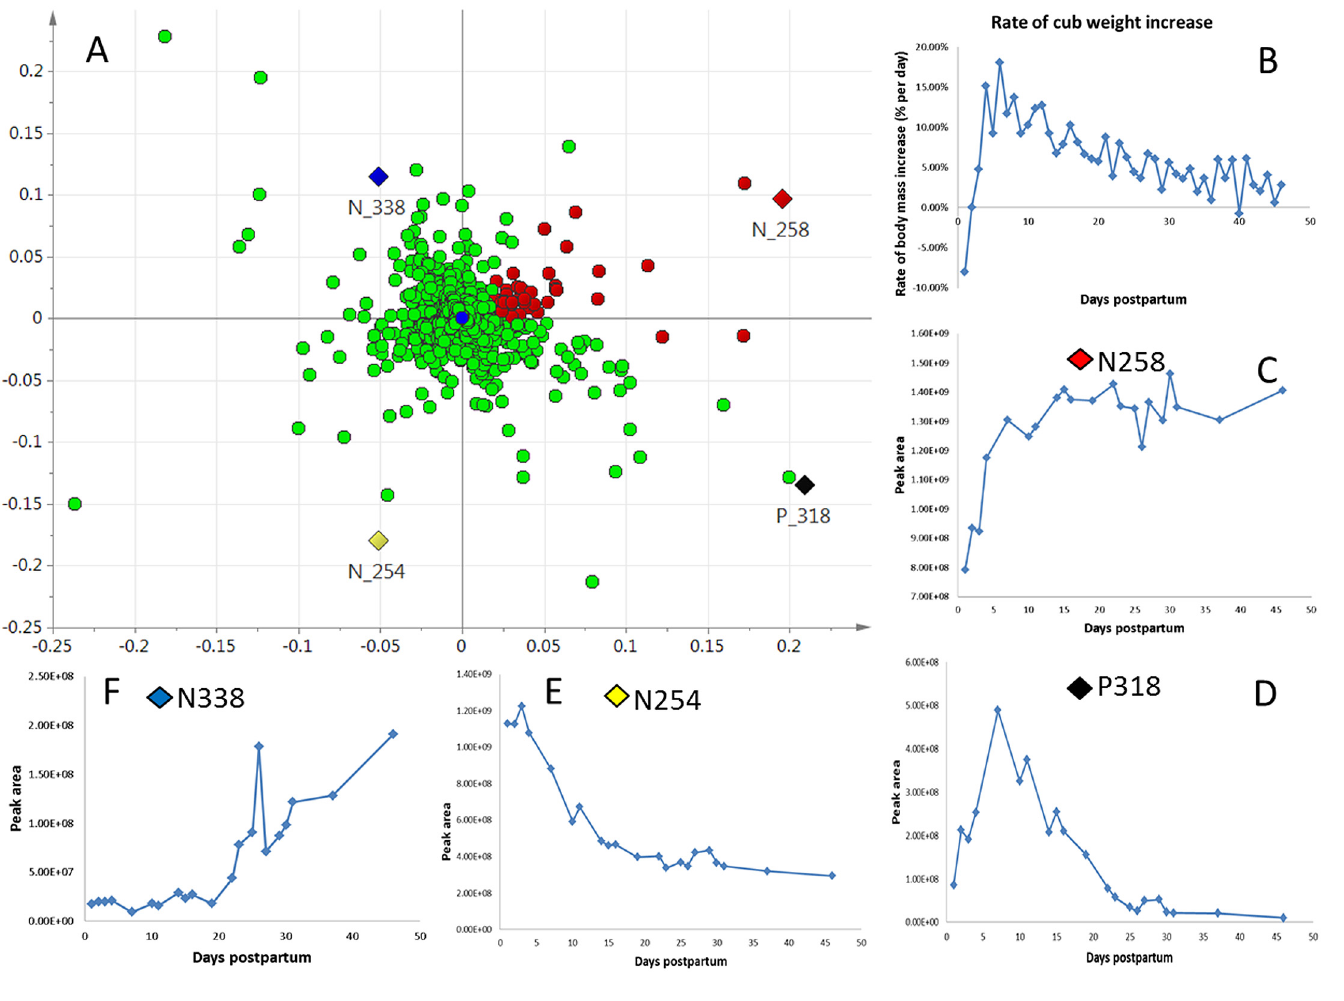
Fig 3. Compounds in giant panda milk tentatively correlated with cub growth rate. (A) OPLS loading plot for 21 serially collected samples from giant panda Yuan Yuan (YY). Components selected for testing for correlation with rate of cub body weight change are highlighted in red; see main text for selection criteria. X-variables, Pareto scaled LC-HRMS data; Y-variable, rate of body weight change over time of YY ’ s cub. (B) Body mass changes for YY ’ s cub over the milk sampling period (see also Fig A in S1 File). (C, D, E, F) Changes in abundance with time of the compounds indicated with diamonds in (A) selected to illustrate diverse correlations with weight gain by the cub. Compound N258 showed positive correlation, whereas compound N254 showed negative correlation, and compound P318 exhibited a more complex pattern. Y-axes represent relative abundances of each compound as estimated from areas under peaks calculated from HILIC-HRMS data, x-axes represent time after birth. Putative initial identifications were N258, isoglobotriose; P318, methyl-imidazole acetate; N254, citrate; N338, 3-methyl-2-oxopentanate.